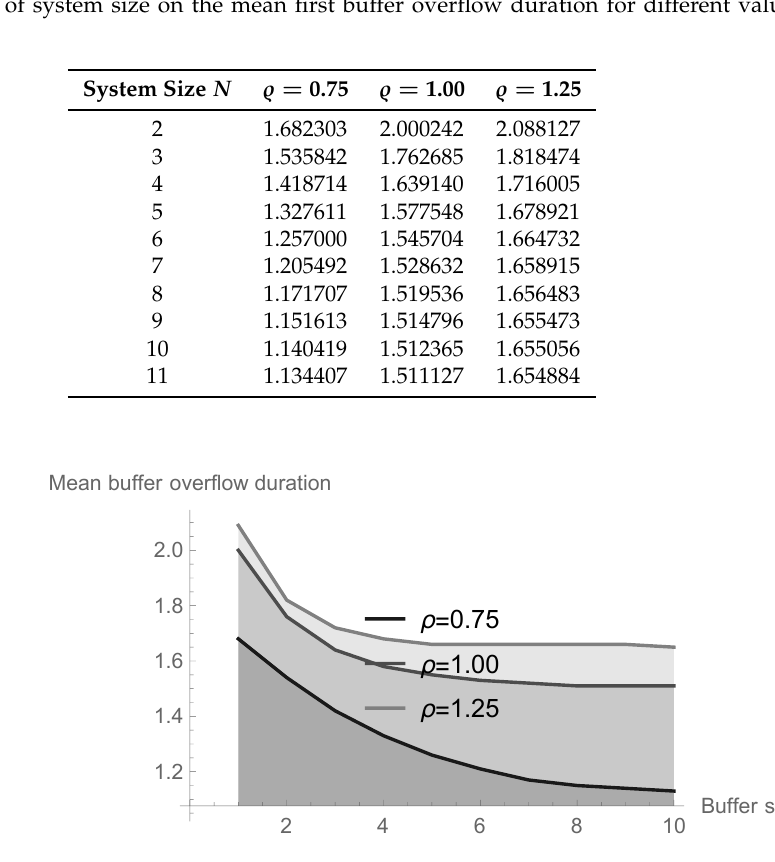
Figure 12. Impact of of system size on the mean first buffer overflow duration for different values of offered